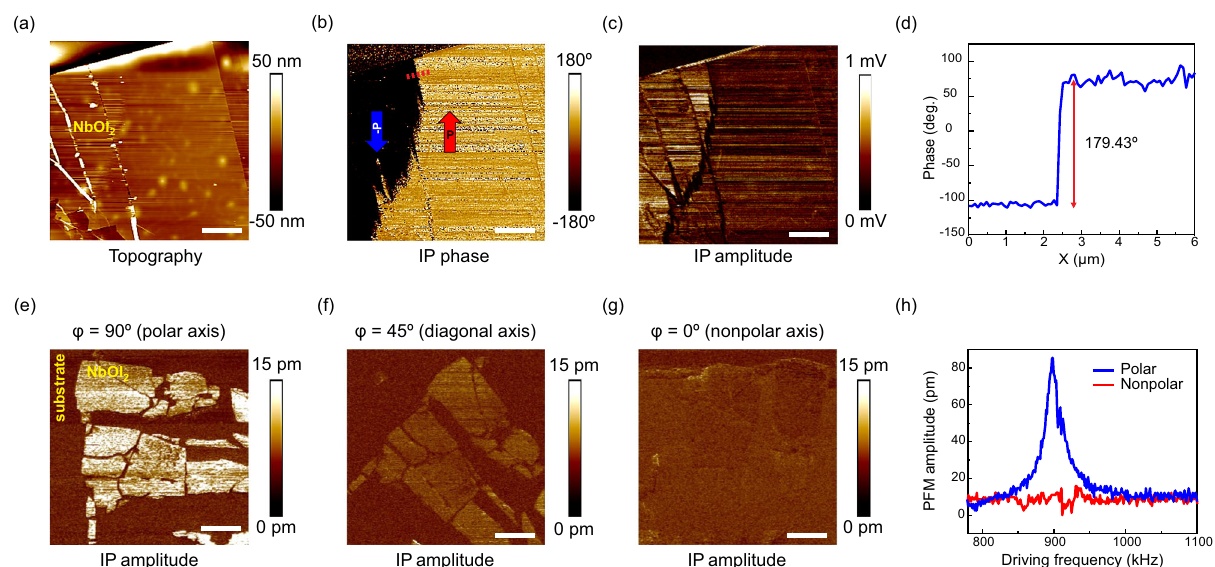
Fig. 4 Piezoelectric force microscopy (PFM) investigation of thin NbOX 2 . a Topography, b In-plane (IP) phase, c IP amplitude, and d phase pro fi le across antiparallel polarization states of 82-nm-thick NbOI 2 fl ake. e – g Vector PFM IP amplitude images of 10-nm-thick NbOI 2 showing spontaneous polarization at 90° e , 45° f , and 0° g angles relative to the cantilever long axis. h PFM amplitude pro fi les along the polar and nonpolar axes of the 10-nm-thick NbOI 2 fl